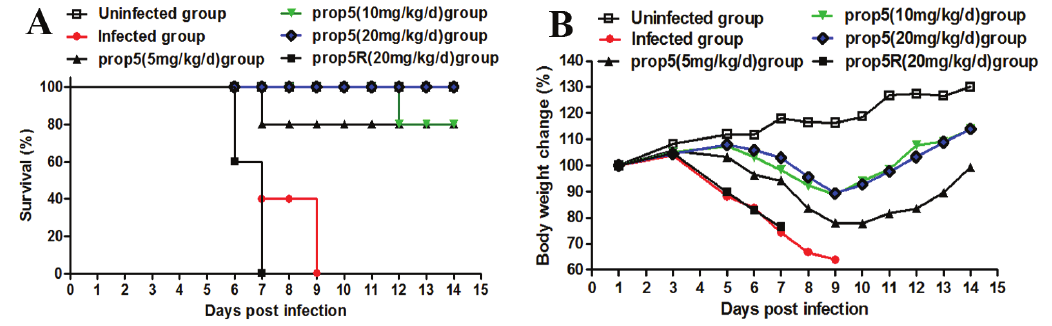
Figure 1. Effects of prop5 on survival rate and body weight loss in infected mice. BALB/c mice were pretreated with normal saline, prop5 (5, 10, 20 mg/kg/day, respectively) and prop5R (random sequence control of prop5, 20 mg/kg/day) dissolved in normal saline at 30 min and 24 h before infection. After drug pretreatment, each mouse was infected intranasally with 400 PFU of A/FM/1/47 (H1N1) in sterile normal saline or normal saline only (uninfected group) at a total volume of 20 μ L. Mice ( n = 10 in each group) were monitored for 14 days starting from virus infection. ( A ) Effects of prop5 on survival of infected mice; ( B ) Effects of prop5 on body weight loss of infected mice. Changes in body weight were based on the initial starting average weight at infection day. The results shown of body weight loss were the average values of body weights of living mice in each group.